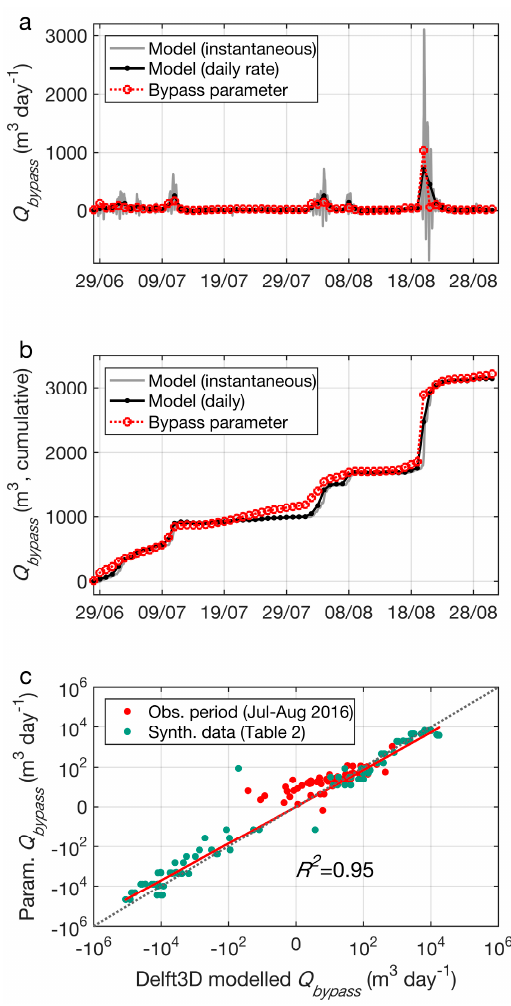
Figure 12. Performance of the headland bypass parameter ( Q bypass ), including the following: ( a ) timeseries of instantaneous and daily bypass rates for Delft3D model simulation compared against over the 2-month period of the ADCP deployment; ( b ) a comparison of cumulative rates of bypassing; and ( c ) a linear correlation of Delft3D predicted bypass against parameterised ( Q bypass ) rates, for simulation of the 2-month ADCP deployment period (red dots) and synthetic wave-tide simulations (green dots).